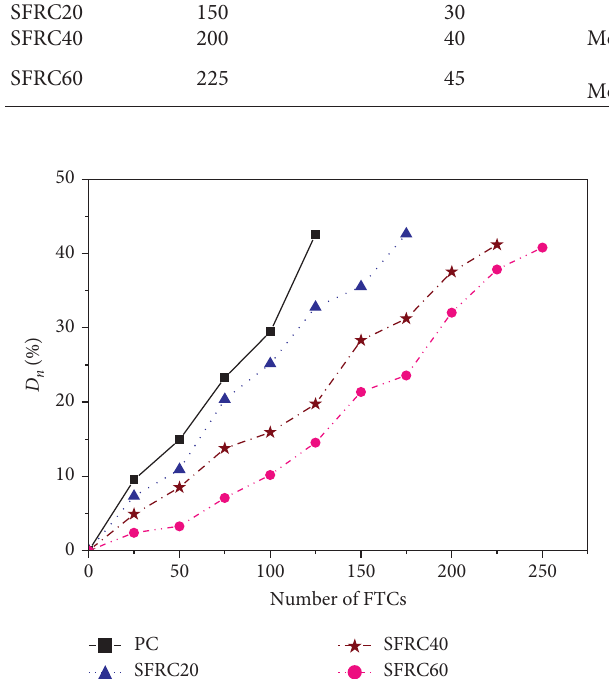
Figure 4: Frost damage of the samples with different FTCs.